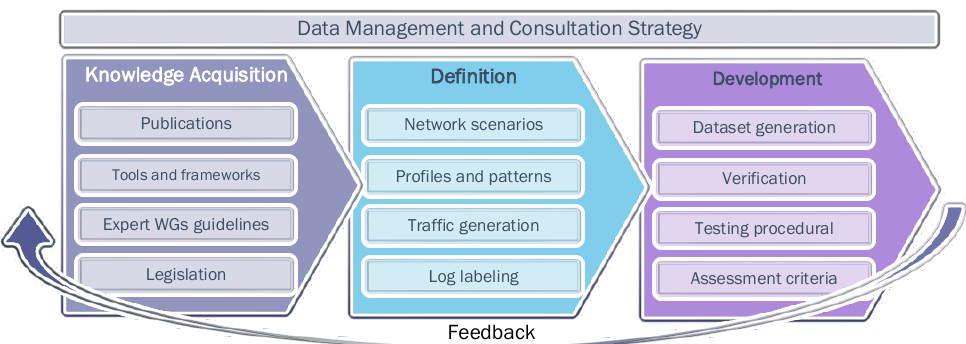
Figure 1. CYSAS-S3 research development